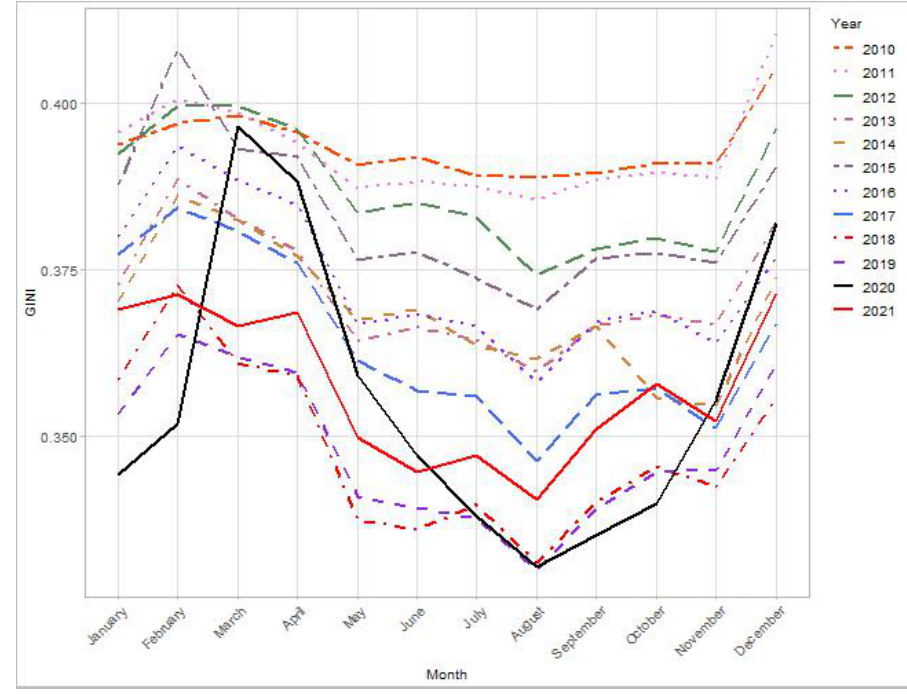
Figure 2. Gini index: females, age group 25–34. Table 1. Summary statistics of the Gini